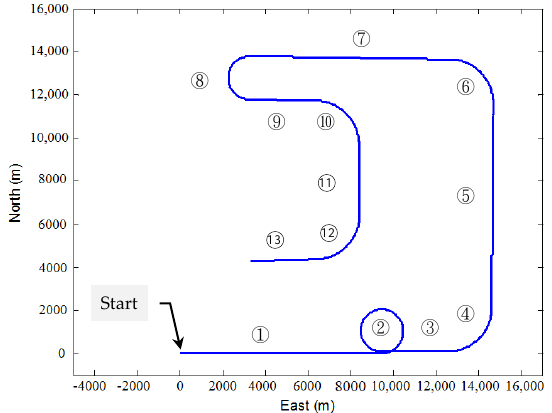
Figure 4. Two-dimensional vehicle trajectory for Scenario 1. Sensors 2016 , 16 , 1167